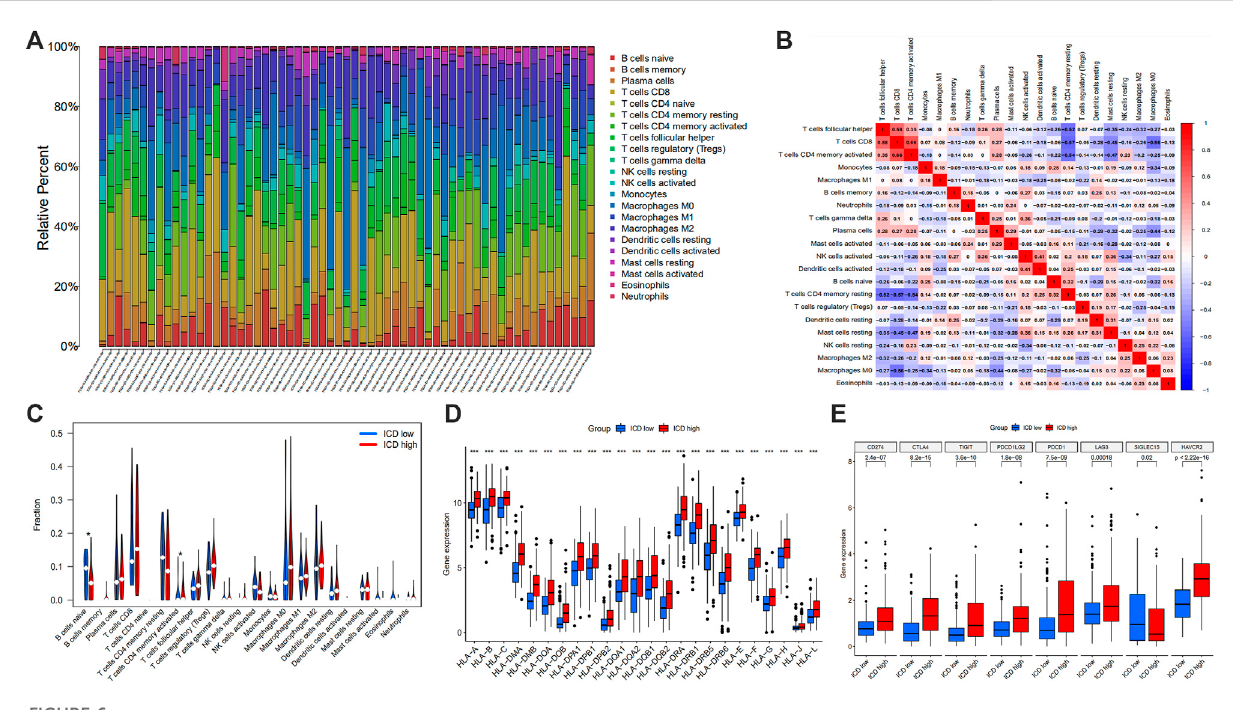
FIGURE 6 Histogram showing 22 types of TIILs in each case (A) , the correlations between the TIILs (B) , comparison of the immune cell fractions (C) , HLA (D) and immune checkpoint associated gene expression (E) between ICD high and ICD low groups. (TIILs: tumor-in fi ltrating immune cells, HLA: Human Leukocyte Antigens, ICD: immunogenic cell death; * p < 0.05; ** p < 0.01: *** p <